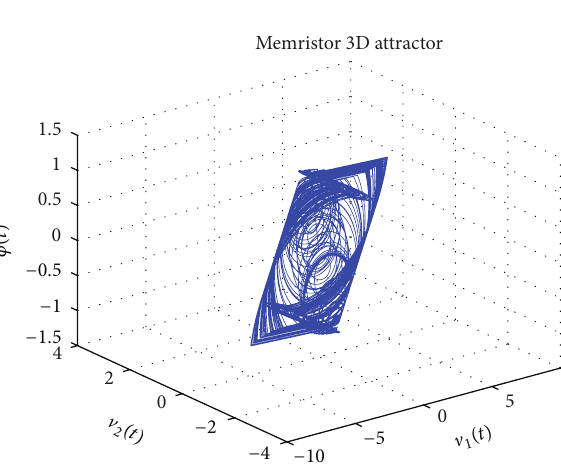
Figure 5: Chaotic attractor of system (3).